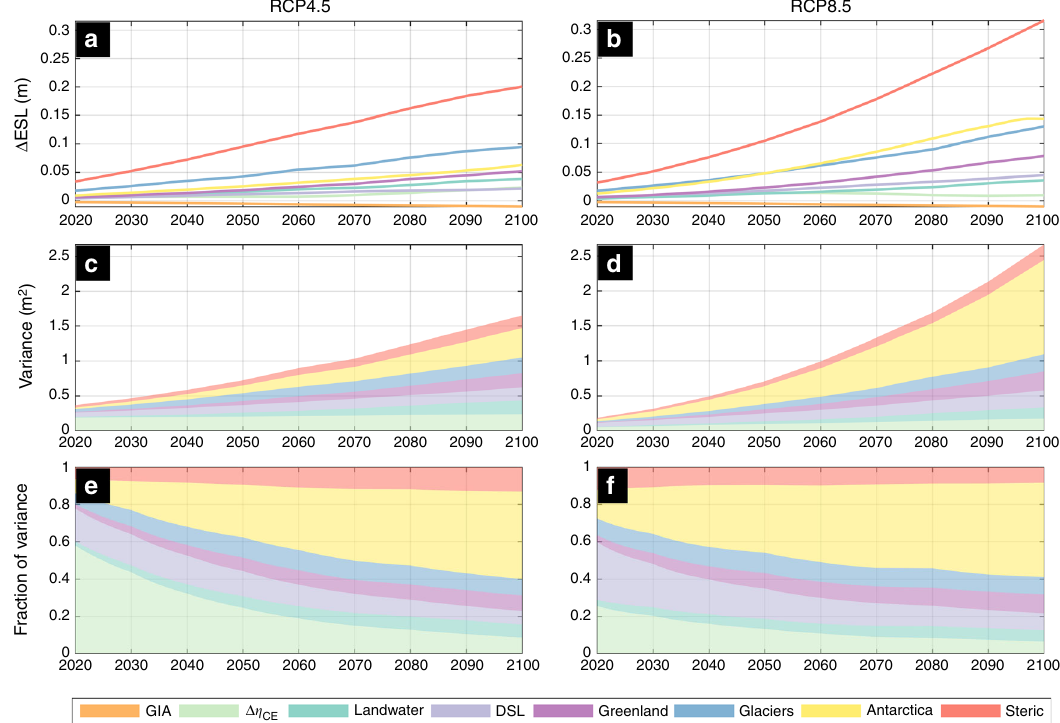
Fig. 5 Break-down of projected ESL contributions and of their uncertainty. Projected increase of the 100-year ESL from changes in climate extremes, the high tide water level, as well as from SLR contributions from Antarctica, land-water, Greenland, glaciers, dynamic sea level (DSL), glacial isostatic adjustment (GIA), and steric-effects ( a , b ); variance (in m 2 ) in components ( c , d ) and fraction of components ’ variance in global ESL change ( e , f ); under RCP4.5 ( a , c , e ) and RCP8.5 ( b , d , f ). Colors represent different components as in the legend and values express the global mean of the